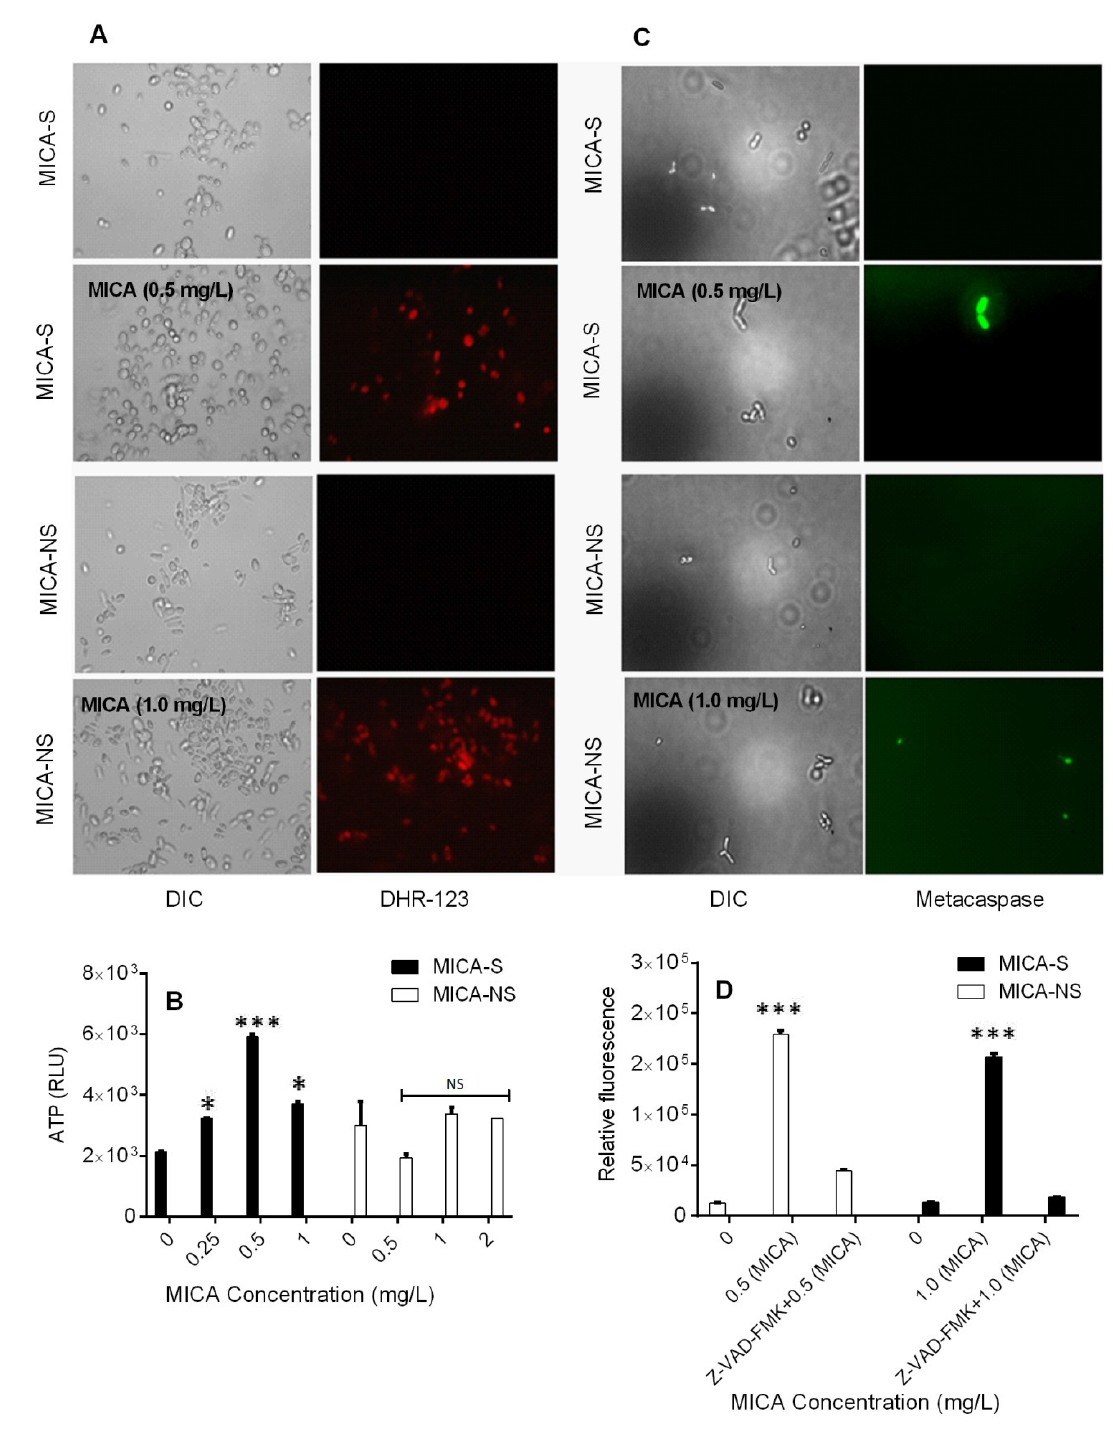
FIGURE 1 : Intracellular ROS accumulation, ATP release and activation of caspase like activity in C. parapsilosis (MICA-S and MICA-NS iso- lates 1 and 6, respectively) cells treated with micafungin for 3 h at 37°C. (A) Fluorescence images of MICA-S and MICA-NS strains of C. par- apsilosis treated with micafungin and stained for intracellular ROS with DHR-123. (B) ATP release assay indicating C. parapsilosis cell mem- brane disruption and plasma membrane leakage after micafungin treatment. (C) Fluorescent images of MICA-S and MICA-NS C. parapsilosis strains treated with micafungin and stained with caspase activity detection marker CaspACE FITC-VAD-FMK. (D) Relative fluorescence of C. parapsilosis MICA-S and MICA-NS cells treated with micafungin with or without caspase-1 inhibitor Z-VAD-FMK, and stained with caspase activity detection marker CaspACE FITC-VAD-FMK. DIC, Differential Interference Contrast; Cp , C. parapsilosis ; RLU, relative light units; *P < 0.05; ***P < 0.0001; NS (non-significant), P > 0.05 (compared with untreated